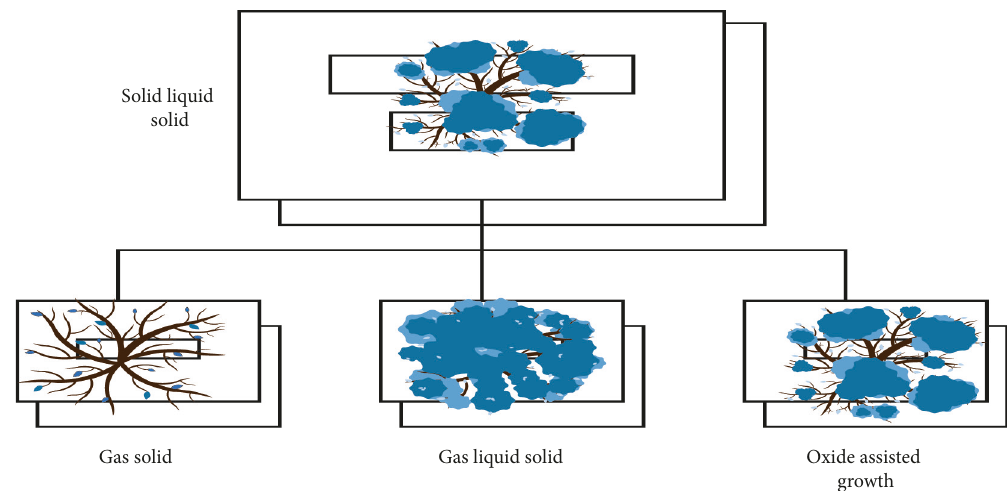
Figure 2: Growth mechanism and types of silicon carbide. Table 1: Composition of various silicon carbide materials. Material